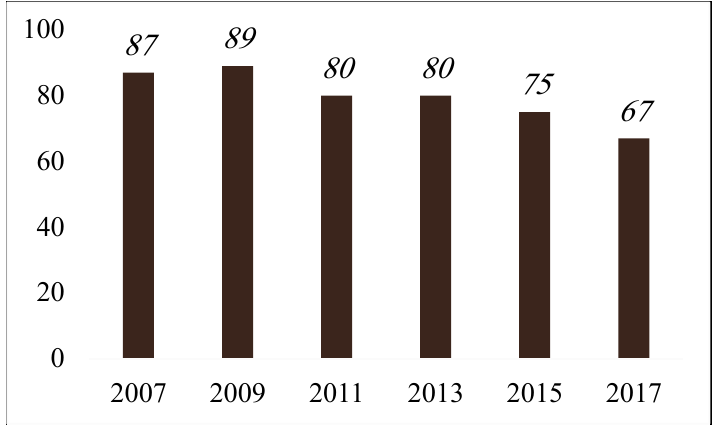
Fig. 2. The ranking level of Vietnam’s tourism sector in